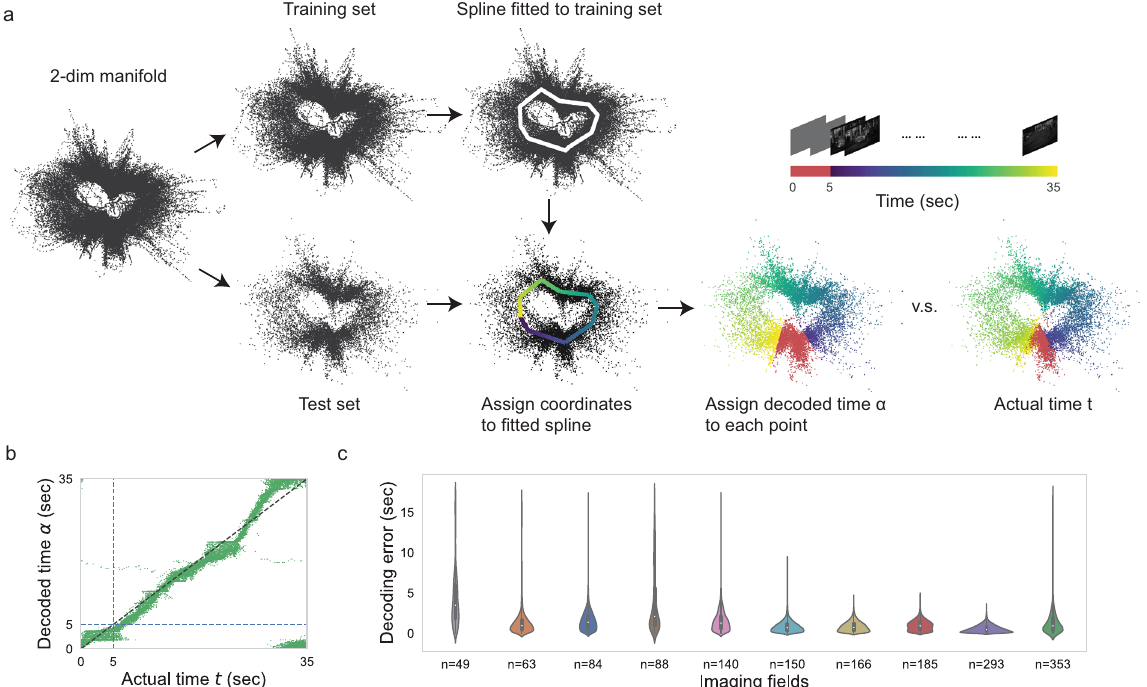
Fig. 5 The manifold mediates a stable representation of the time within the movie clip. a Illustration of the unsupervised method with data from the example imaging fi eld ( n = 140): fi rst, we projected reconstructed DF/F responses into the fi rst two Isomap dimensions, each dot denotes instantaneous population activity; second, we randomly pick 80% of the instantaneous population activity as training set and rest of them as test set; third, we fi tted a spline to the neural manifold of the training set and assigned coordinates with randomly picked origin to the fi tted spline; fi nally, we shifted and fl ipped the coordinates on the fi tted spline to match with the actual time and assigned decoded time to each point in the test set by its nearest coordinate on the spline. b Decoded time from the neural manifold plotted against actual time in the movie for the example imaging fi eld ( n = 140, 12,600 timepoints). c Violin plots showed decoding error (absolute circular difference between decoded time and actual time) for all the imaging fi elds (14,700 timepoints for imaging fi eld n = 63, 84, 185, 293, and 353; 12,600 timepoints for imaging fi eld n = 140, 166; 10,500 timepoints for imaging fi eld n = 49, 88, and 150). Inner boxplots show median: center white point; interquartile range: box; and data range (maximum 1.5 interquartile range): whiskers. Imaging fi elds were ordered by the number of recorded